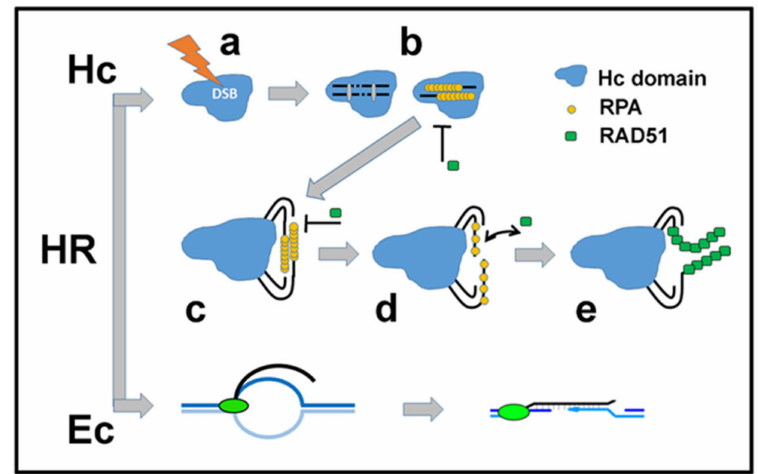
Figure 5. The proposed mechanism underlying the multistep regulation of homologous recombina- tion (HR) based on chromatin architecture at the multiscale. HR is activated by the microarchitecture of heterochromatin (Hc) domains and highly transcribed gene loci (euchromatin; Ec). In euchro- matin, the HR machinery preferentially recognizes transcription-related structures (transcription forks, R-loops) within intensively transcribed loci and ensures their precise repair (bottom); however, in heterochromatin, HR is the pathway of choice for the complex (dense) architecture but may be very risky due to the presence of repetitive sequences. Hence, HR in heterochromatin must be precisely regulated in multiple steps associated with or even controlled by changes in chromatin architecture. ( a ) Double-strand break (DSB) induction within the heterochromatin domain is followed by ( b ) resection of DNA ends, which is initiated and proceeds within the Hc domain. Single-stranded